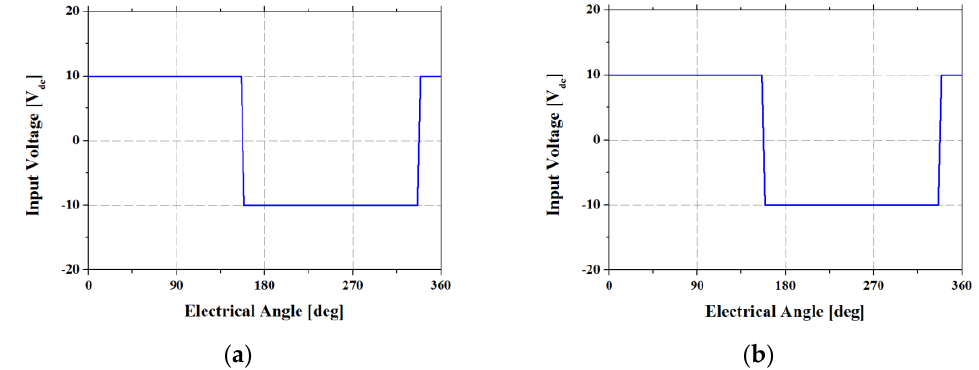
Figure 16. Comparison of the input voltage waveforms of the base and proposed models: ( a ) base model; ( b ) proposed model.